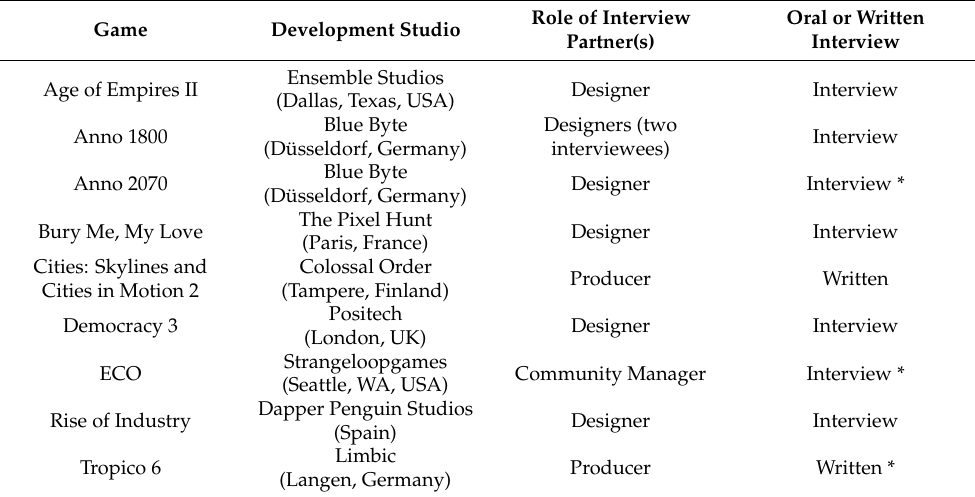
Table 1. This is a table. Overview of the conducted developer interviews (* in German, translated for this